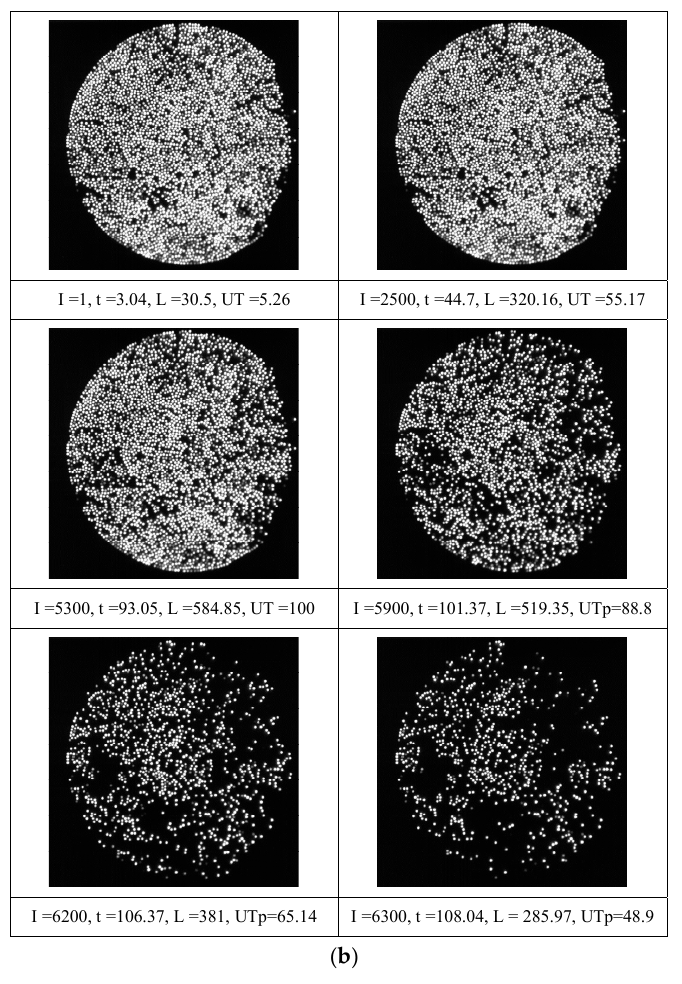
Figure 6. ( a ) Typical graph showing the normalised transmitted light intensity and applied load as a function of time for three different samples of the SDOF bundles; ( b ) Illustration of the fracture sequence of the filaments in the SDOF bundle.